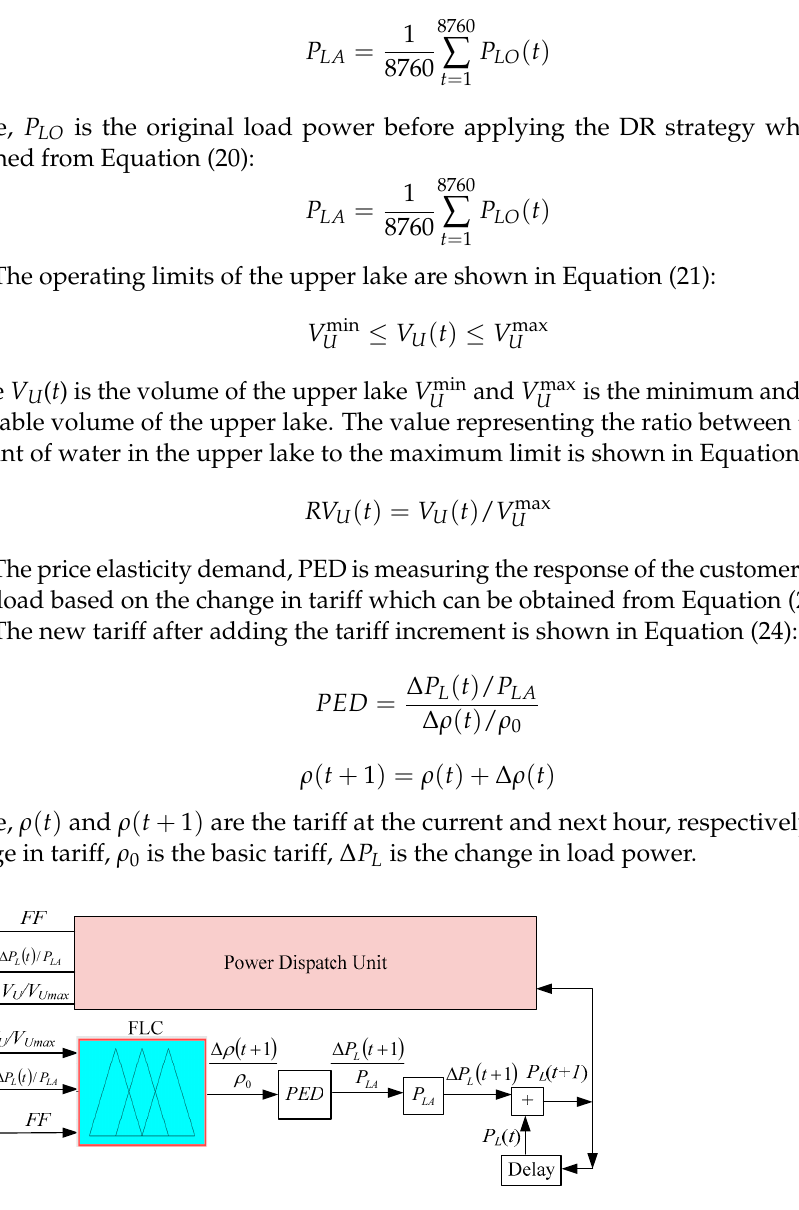
Figure 6. The structure of FLC.